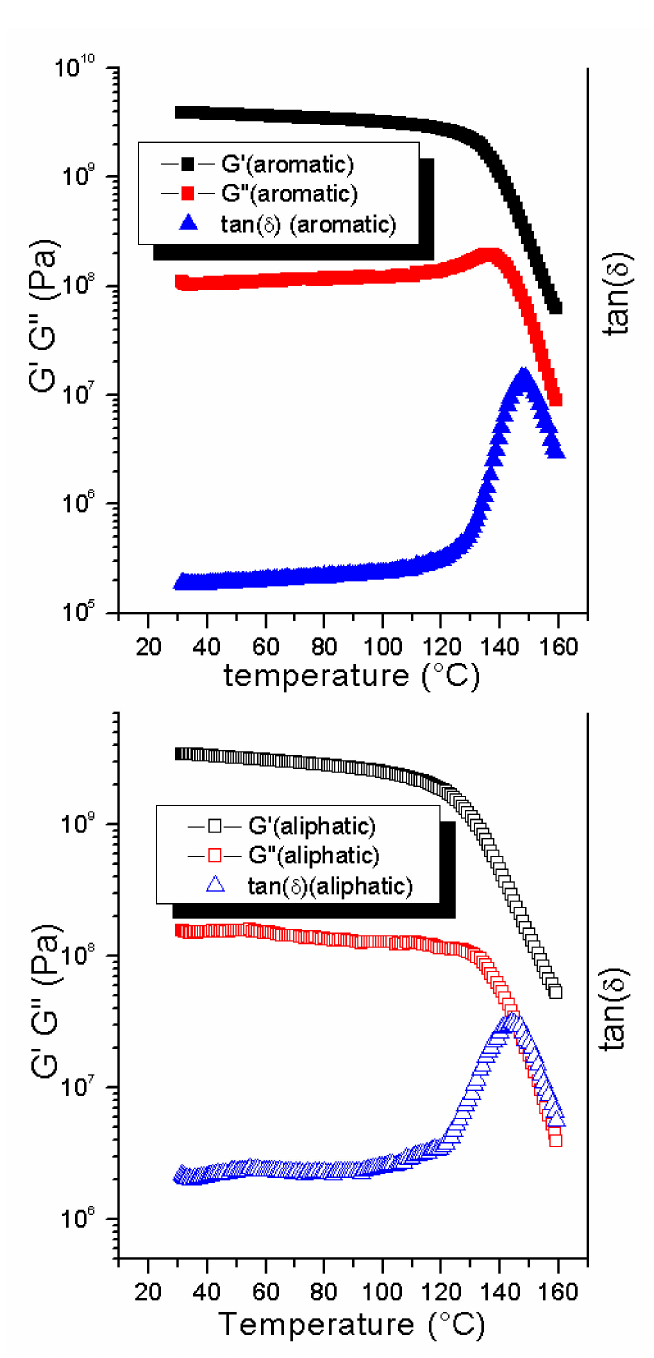
Figure 7. DMTA measurements of aromatic ( top ) and aliphatic ( bottom ) crosslinkers. During cooling, the material was expected to re-form the DA crosslinks that had been broken at high temperatures by the RDA reaction (which is dominant at these elevated temperatures). If the DA reaction is performed consistently, the material should display the same mechanical properties in all subsequent cycles. A relatively large change in properties was observed between the first and second cycle; this is consistent with the shift observed in DSC, and the explanation given of a kinetically favored orientation (endo vs. exo) still holds true. However, after each consecutive cycle, the softening point of the material increased. If the only equilibrium involved is the changing from an endo to exo